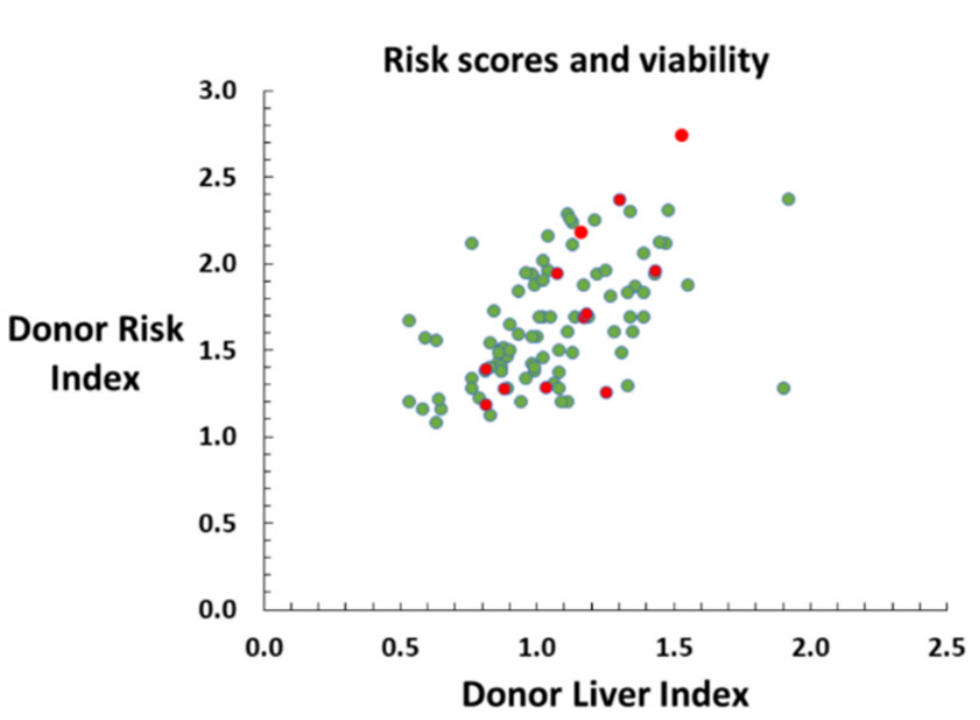
Figure 2. Normothermic machine perfusion viability assessment of 100 liver grafts from deceased brain-dead donors with the intent to transplant. Scatter plot demonstrating relationship between